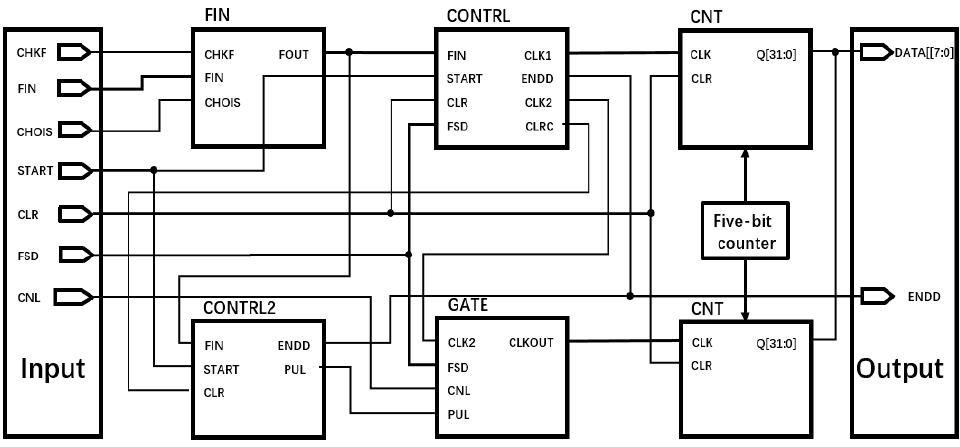
Figure 2. Equal precision digital cymometer circuit systematic diagram.